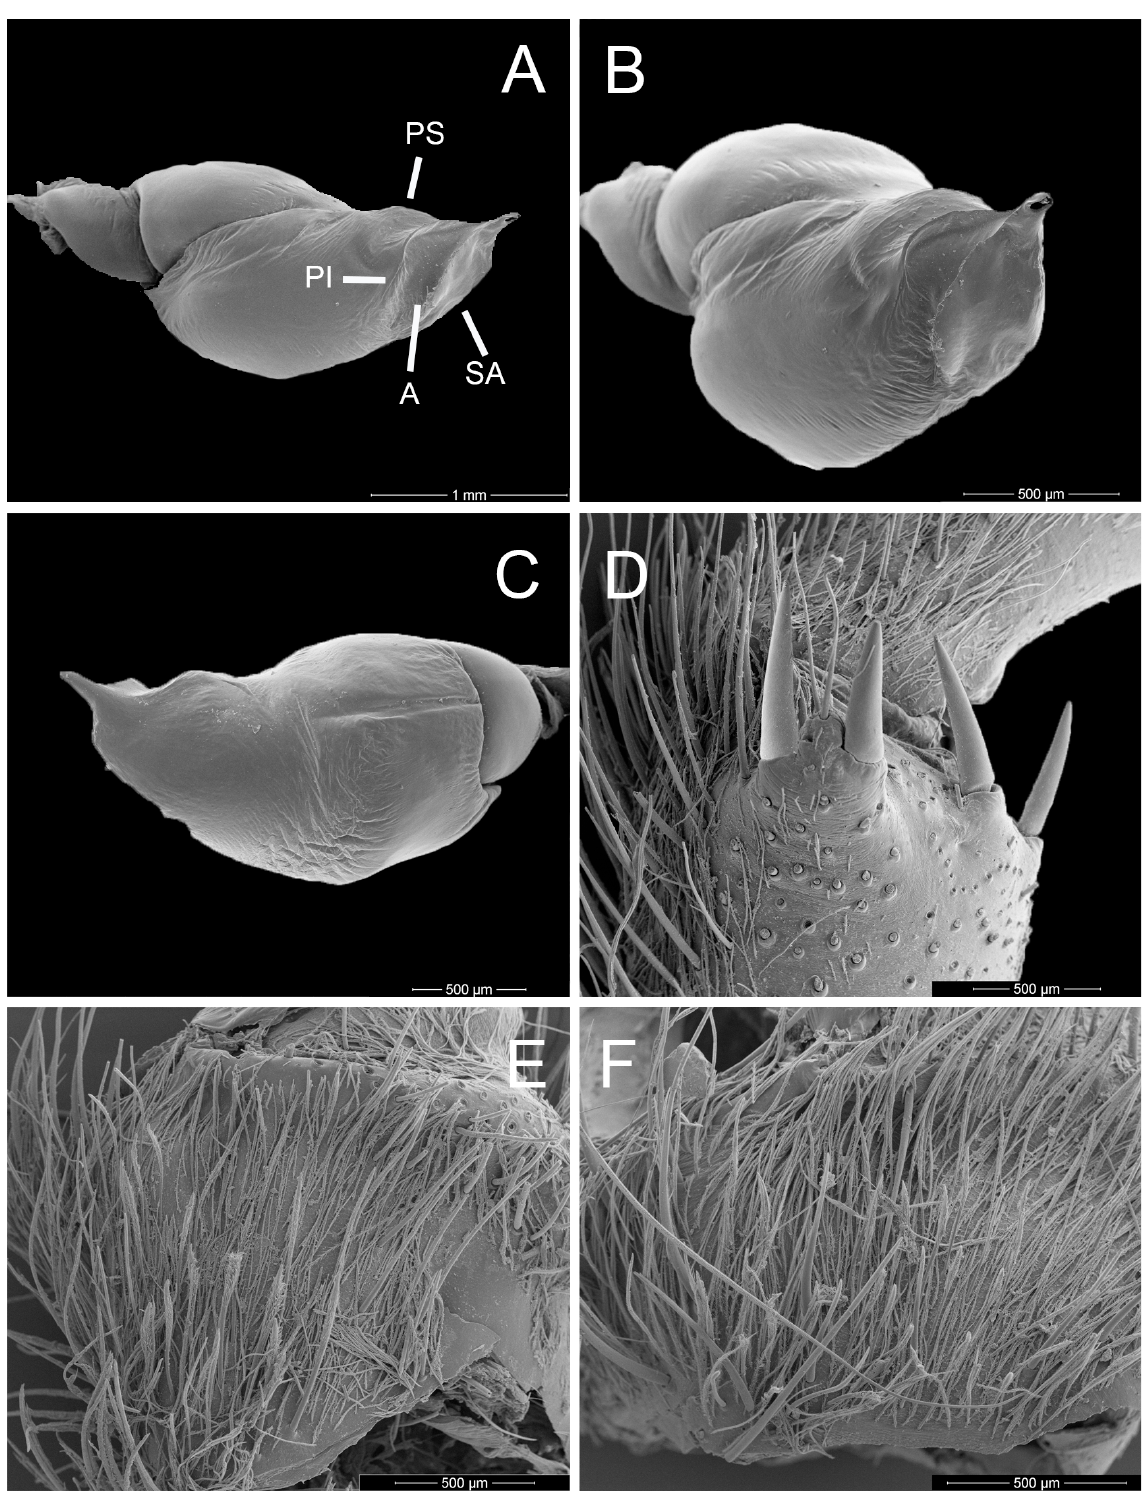
Fig. 14. Umbyquyra schmidti (Rudloff, 1996) gen. et comb. nov., ♂, Cuiabá, Mato Grosso, Brazil (IBSP 110728), A . Palp prolateral. B . Anterolateral. C . Retrolateral. D . Tibial apophysis, retrolateral. E . Stridulatory organ, palp trochanter. F . Trochanter I. Abbreviations: see Material and